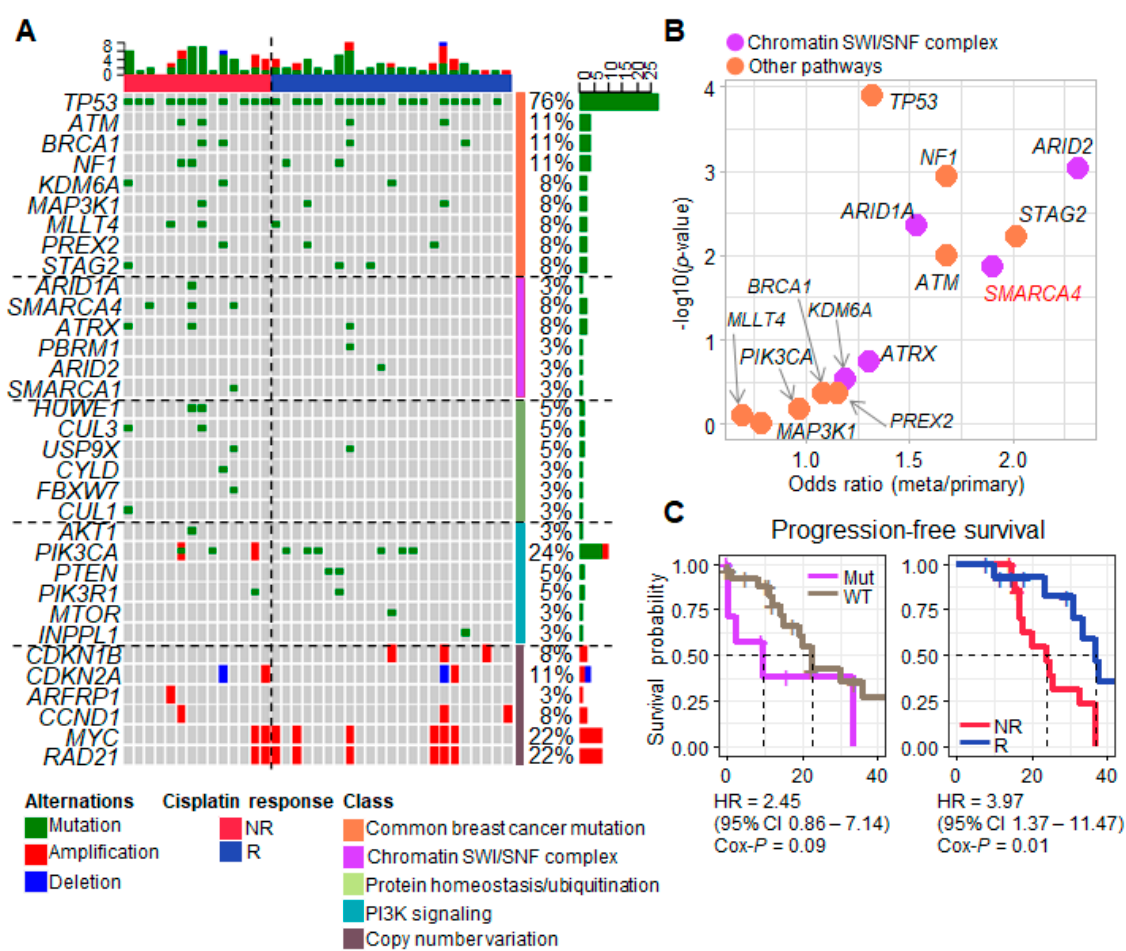
Figure 1. Variant landscape of TNBC according to cisplatin response. ( A ) An oncoplot of variant genes classified by the response of triple-negative breast cancer (TNBC) patients ( n = 37) to cisplatin (NR, nonresponder; R, responder). Driver genes were categorized by oncogene pathways (37). ( B ) A scatter plot of mutated genes in metastatic TNBC. The X axis is the odds ratio (OR) of metastatic-to-primary TNBC, and the Y axis is the p -value calculated by Fisher’s exact test from the contingency table of metastasis and gene mutation cases. ( C ) Progression-free survival (PFS) curves of the TNBC patients who had mutation of chromatin SWI/SNF complex genes and cisplatin response clinical profile (NR: nonresponder; R: responder), respectively. The hazard ratio (HR) and p -value were calculated by Cox proportional regression analysis.